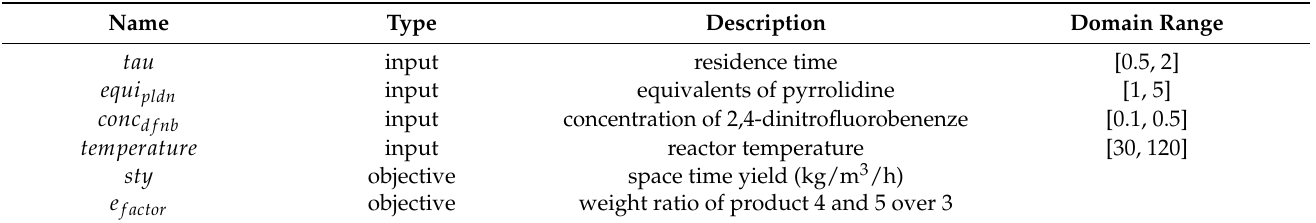
Table 2. The input variables and objectives of Summit